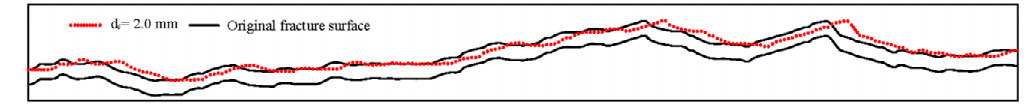
Table 1. Statistical parameters for Gaussian fitting of vertical aperture with different fractures.